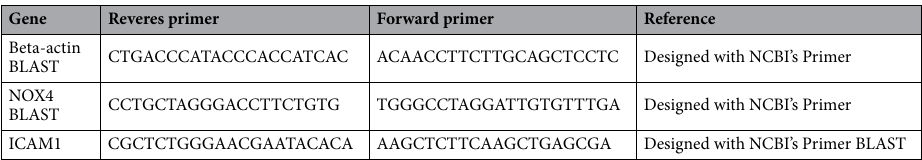
Table 3. Primers for quantitative real-time PCR analysis of gene